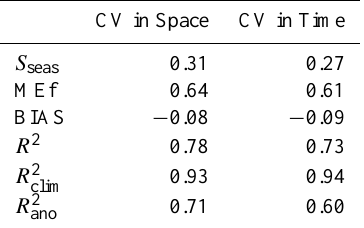
Table 1. Median grid-cell performance of the random forest model with full atmospheric forcing (Eq.